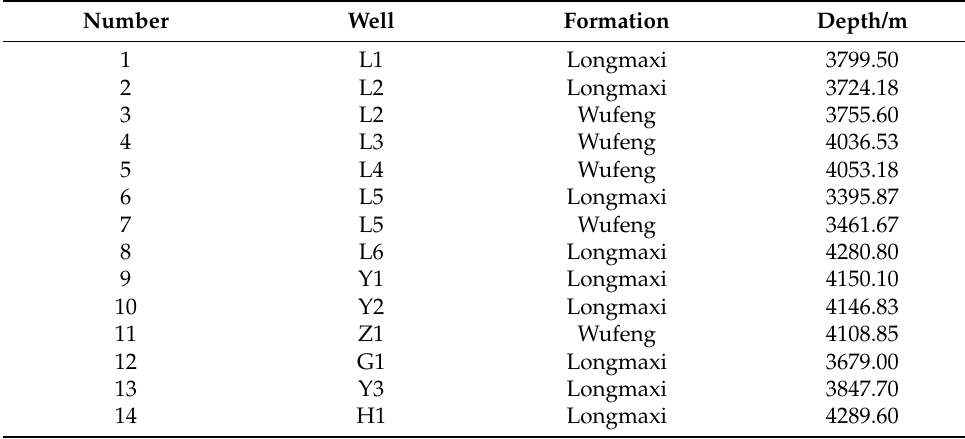
Table 1. Experimental Sample Number, Well Name, and